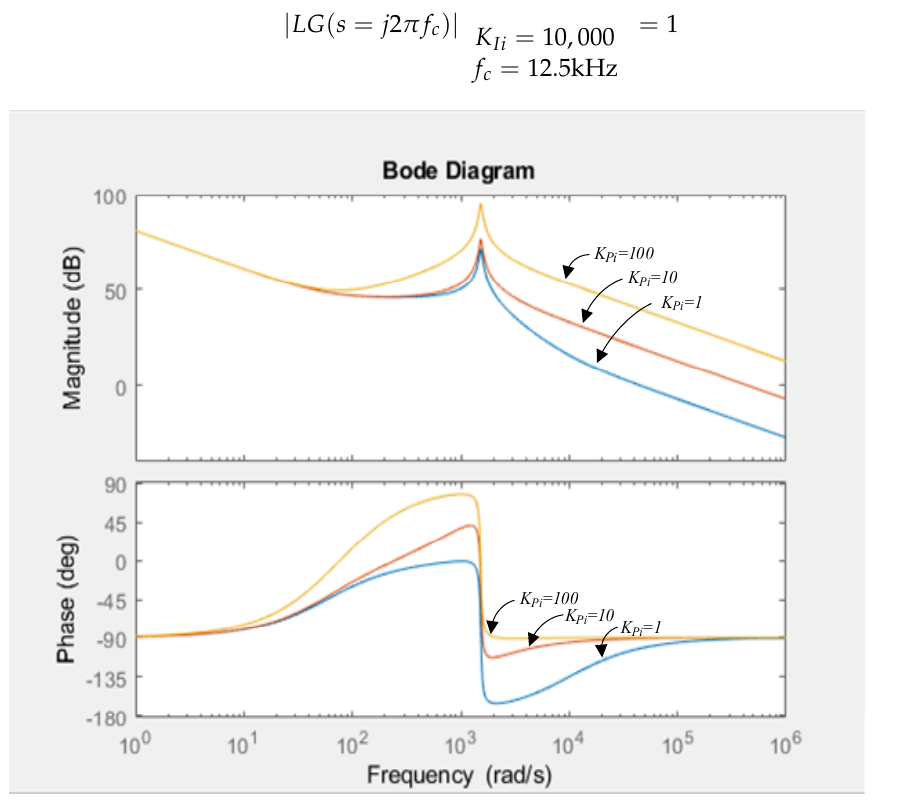
Figure 7. Bode plot of the current loop frequency response for the K Ii = 10,000 under different K Pi